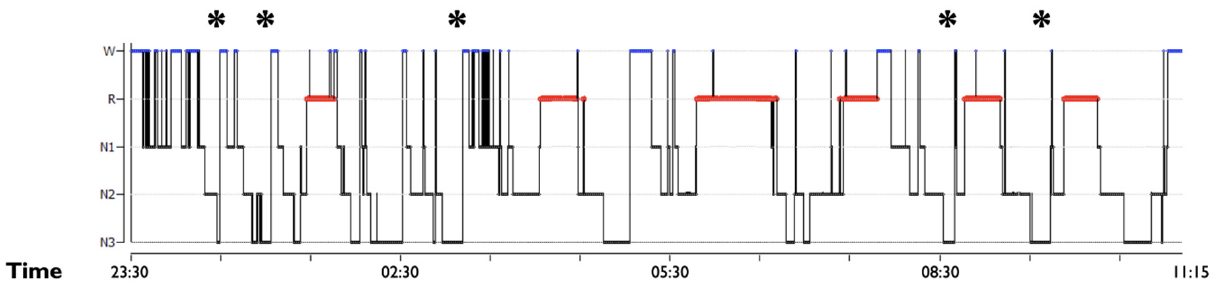
Figure 2. Hypnogram of a patient with DoA. Hypnogram in a 23-year-old DoA patient. The stars (*) indicate the occurrence of DoA episodes during the night. It is noteworthy that N3 is highly fragmented by several awakenings and distributed throughout the night. Some DoA events arise also from the last part of